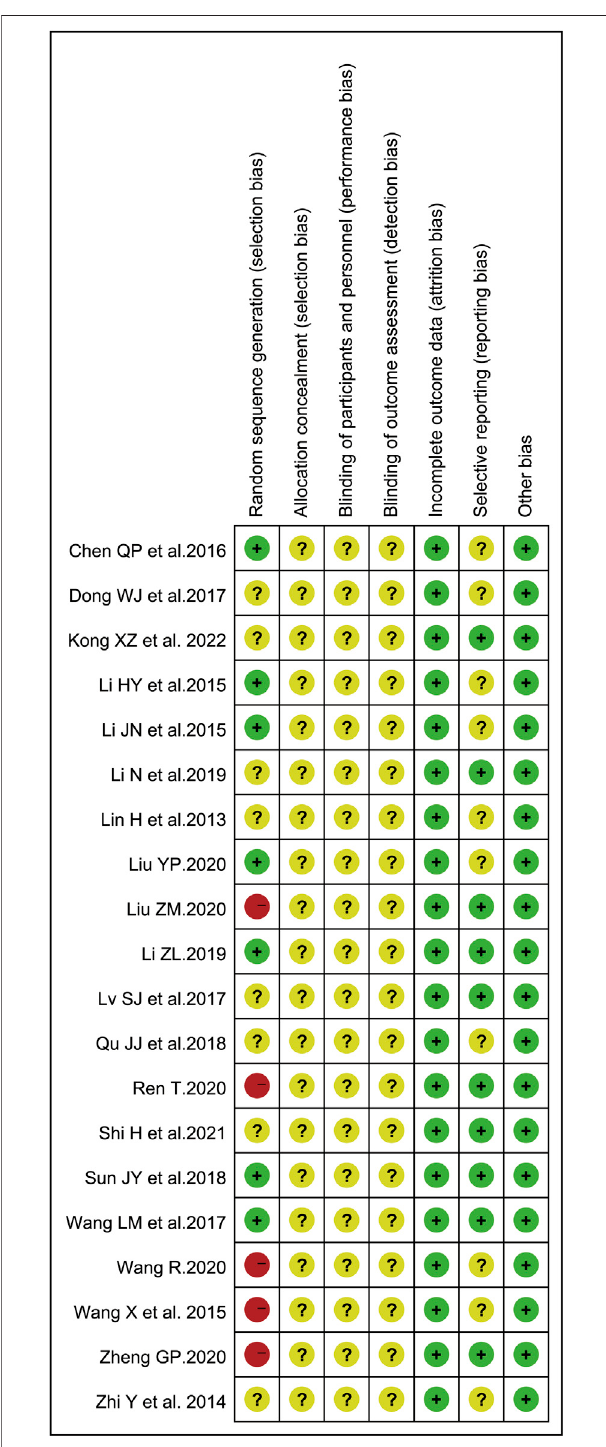
FIGURE 2 | Risk of bias